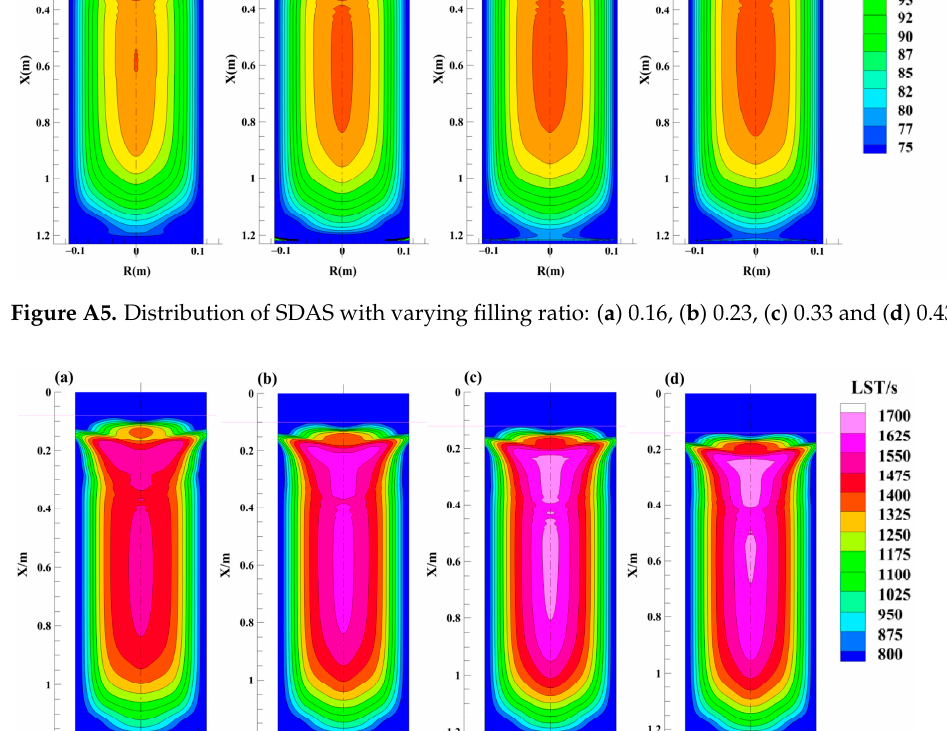
Figure A6. LST distribution with varying slag thickness: ( a ) 0.08 m, ( b ) 0.10 m, ( c ) 0.12 m and ( d ) 0.14 m.